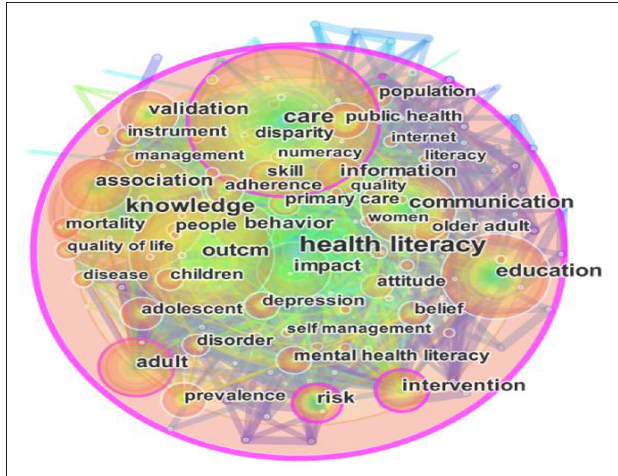
FIGURE 7 | Visualization on co-occurring keywords network.